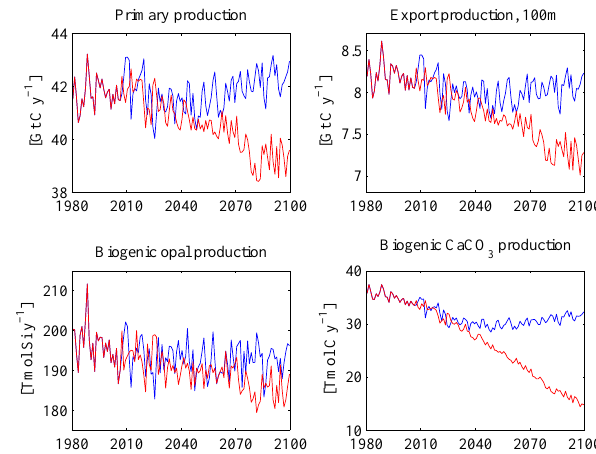
Fig. 19. Calendar time at which monthly average (cid:127) calcite (top) and Fig.17. Calendartimeatwhichmonthlyaverage Ω calcite ( top )and Ω aragonite ( bottom )isfirstbelow1.0( i.e. CaCO 3 (cid:127) aragonite (bottom) is first below 1.0 (i.e. CaCO 3 is undersaturated). isundersaturated). Thepanelsfocusonthenorthandsouthpolarregionssincetheseexperiencethegreatestchanges. The panels focus on the north and south polar regions since these experience the greatest changes.